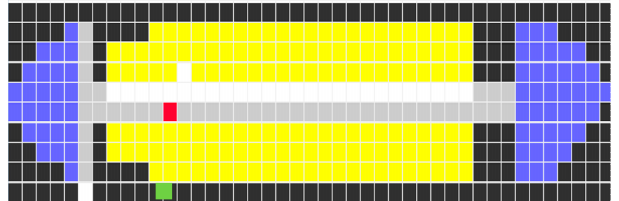
Figure 5. Aircraft Cell-DEVS model.